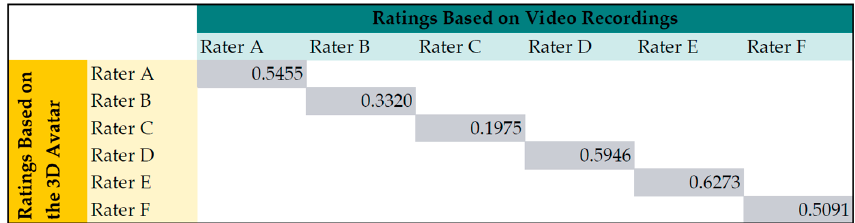
Figure 8. Intrarater reliability for ratings based on video recording and animated 3D avatar. Reliability is computed with weighted kappa coefficient.